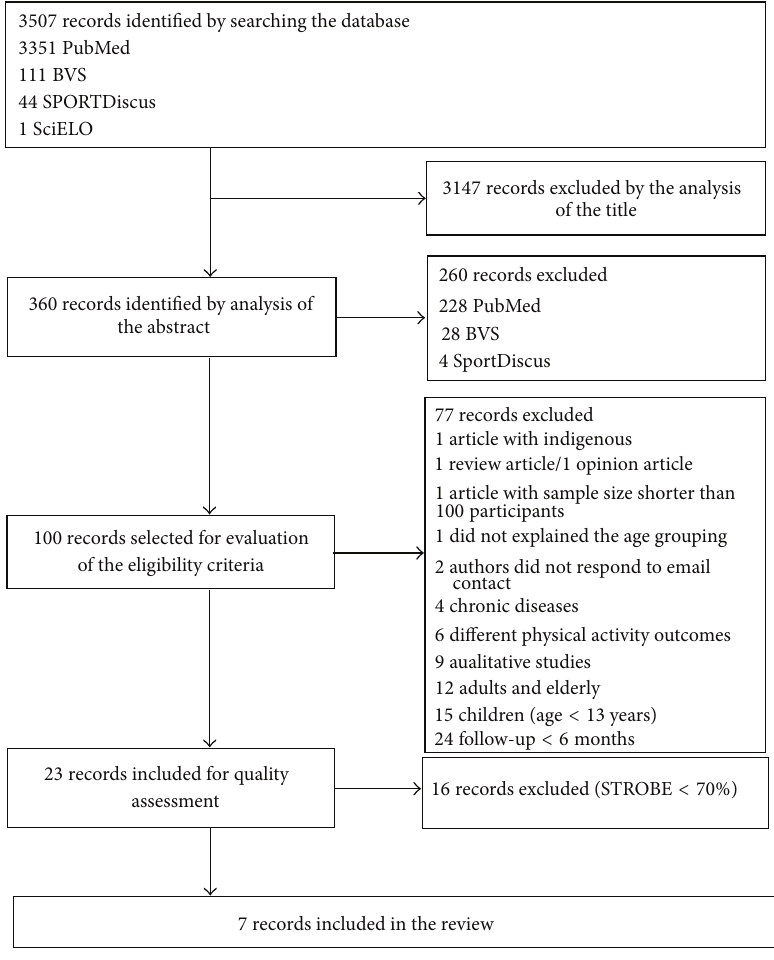
Figure 1: Flowchart of the selection of studies through the inclusion